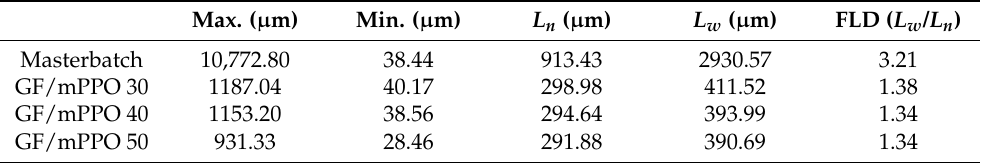
Table 2. The average fiber length of the GF/mPPO masterbatch and composites.